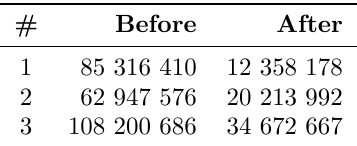
Table 1. The e ff ect of downsampling on three typical point clouds — the number of original points and the number of points after downsampling. One can see that just by downsampling to a 1 cm 3 grid, the size of points goes down to at least